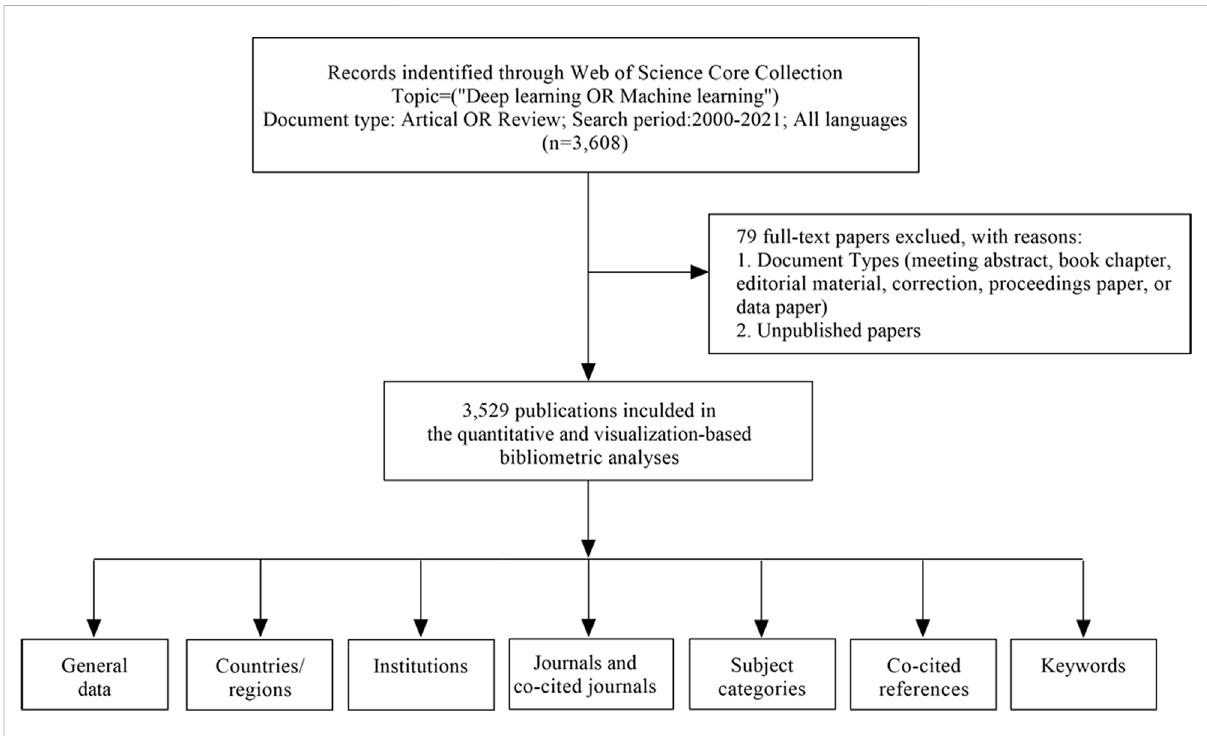
FIGURE 1 Aframe fl owdiagram. ThediagramshoweddetailsselectioncriteriaforABAMpublications fromWoSCC database andthestepsofbibliometric analysis.